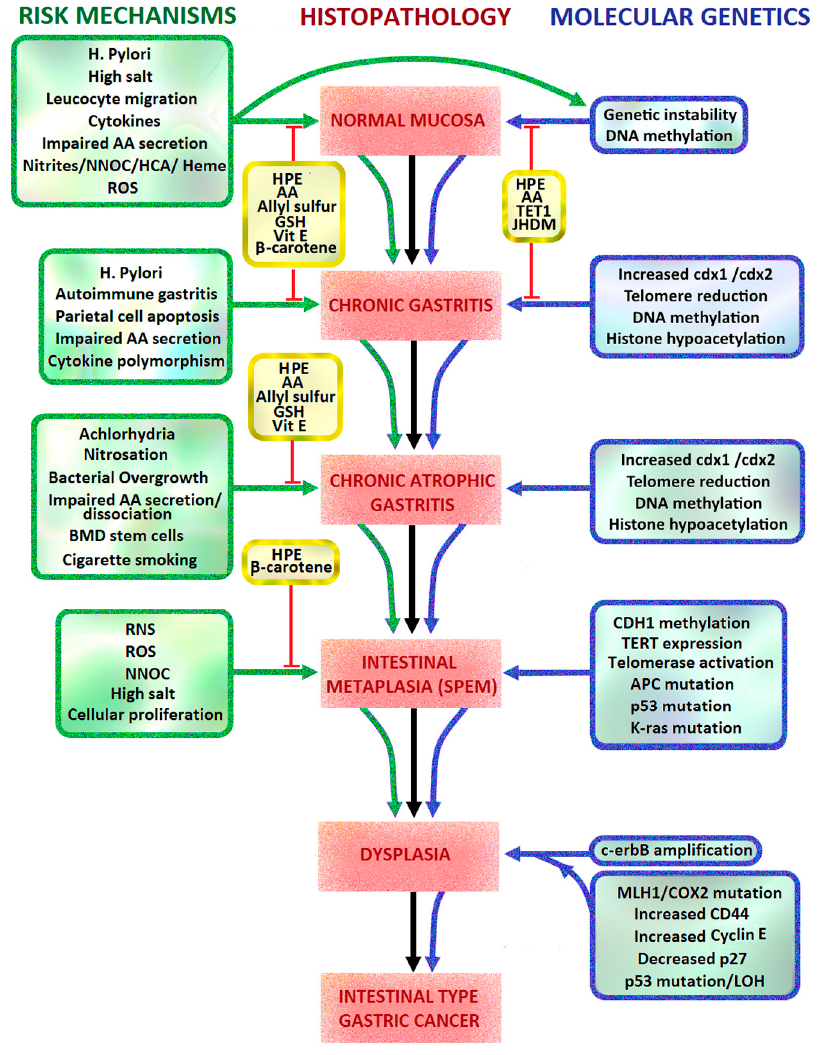
Figure 5. Modern Correa pathway of intestinal-type gastric carcinogenesis, with risk factors and host mechanisms in green, molecular genetics in blue, and preventive factors in yellow. As histological changes progress, antioxidant systems and DNA repair mechanisms become less effective and the epigenetic effects of Helicobacter pylori infection and environmental carcinogens more difficult to reverse. AA: ascorbic acid; BMD: bone marrow derived; cdx: caudal type homeobox gene; c-erbB: human epidermal growth factor oncogene; CDH1: E-cadherin gene; GSH: glutathione; HPE: Helicobacter pylori eradication, LOH: loss of heterozygosity; SPEM: spasmolytic polypeptide-expressing metaplasia; TET1: ten eleven translocation methylcytosine dioxygenase 1